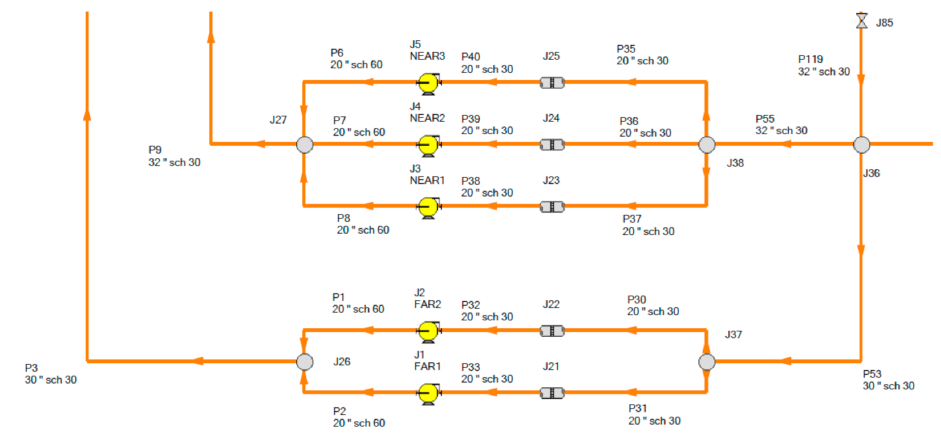
Figure 10. Fathom diagram